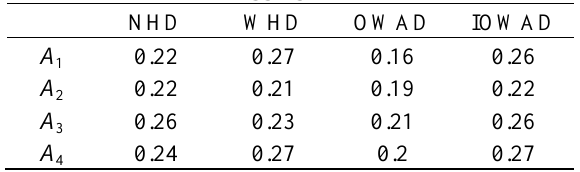
Table 4. Aggregated results 1